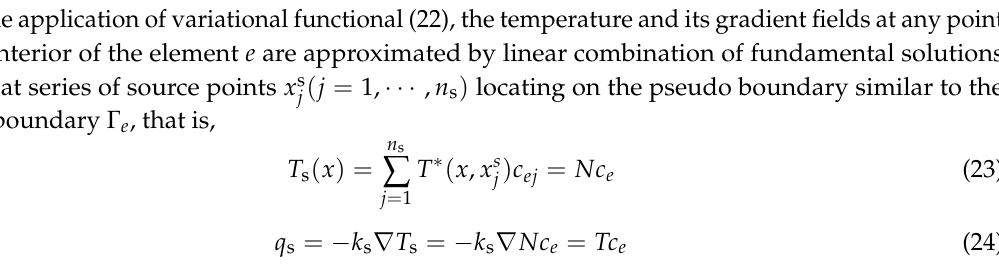
Figure 4. Schematic diagram of two-dimensional hybrid finite element.